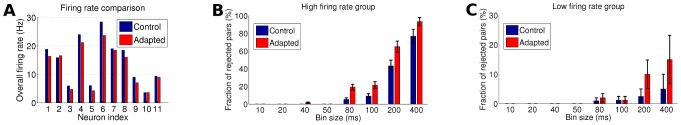
Subpopulation analysis of the data that are presented in Figure 6 C.(A) Overall firing rates of the 11 neurons in the data set from Figure 6 for the control and adaptation conditions. The rates were averaged over all stimuli. ( B) Fraction of neuronal pairs rejected by the maximum entropy test with the mutual information difference as the divergence measure () for the high firing rate (, cf. A) population of neurons. ( C) Same as in B but for the low firing rate population (). Rejection rates were averaged over all neuron pairs and all time bins. Simulated annealing [45] was applied to maximize the p-value (cf. Text S1). Number  of Monte Carlo samples was 1000. The false discovery rate of the rejections was corrected using the Benjamini-Hochberg procedure [35].